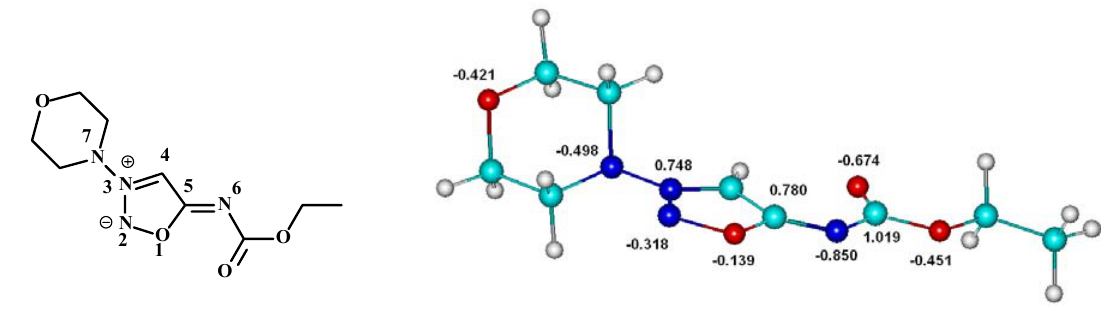
Figure 1 . Chemical formula of molsidomine with formal charges in sydnone ring and optimized structure with ESP atomic